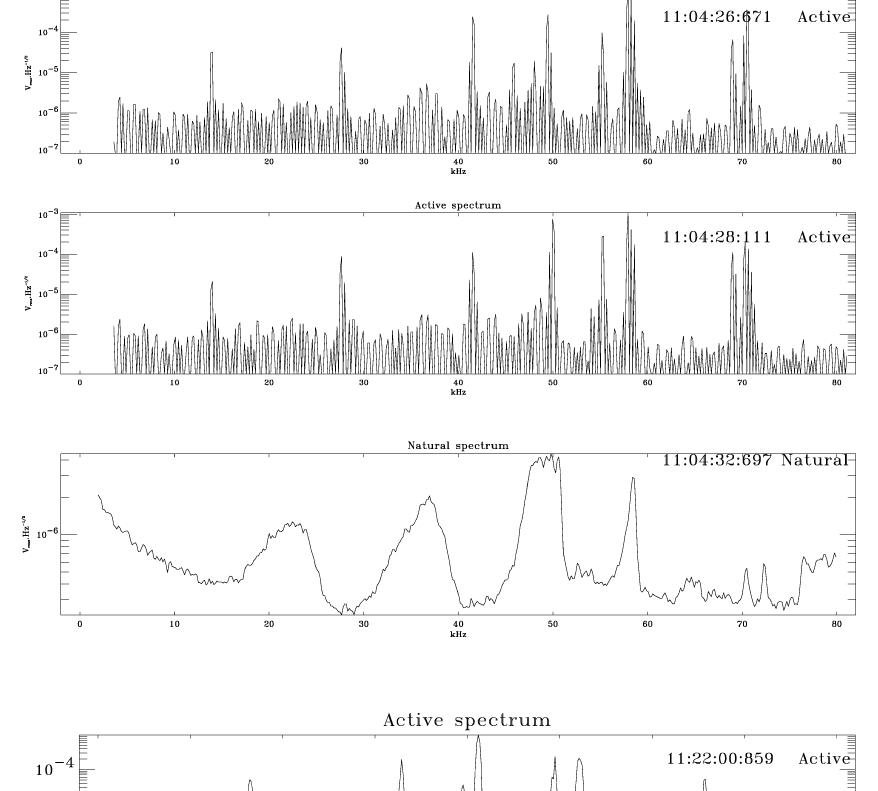
Fig. 8. Consecutive Whisper passive and active spectra from Rumba on 1 October. The natural emissions which lie between Fp at 45.9kHz are seen as a low power resonance on the second active spectrum and with a strong res- onance at Fq at 49.8kHz. The res- onances at Fp and Fuh have disap- peared on the second active spectrum.